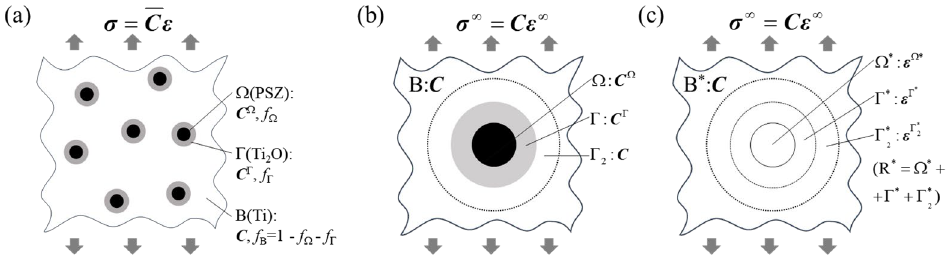
Figure 9. Modeling of a particulate-dispersed composite with double inclusions. ( a ) Original problem of a composite with double inclusions dispersed in infinite matrix; ( b ) a problem equivalent to ( a ); ( c ) a problem equivalent to ( b ).